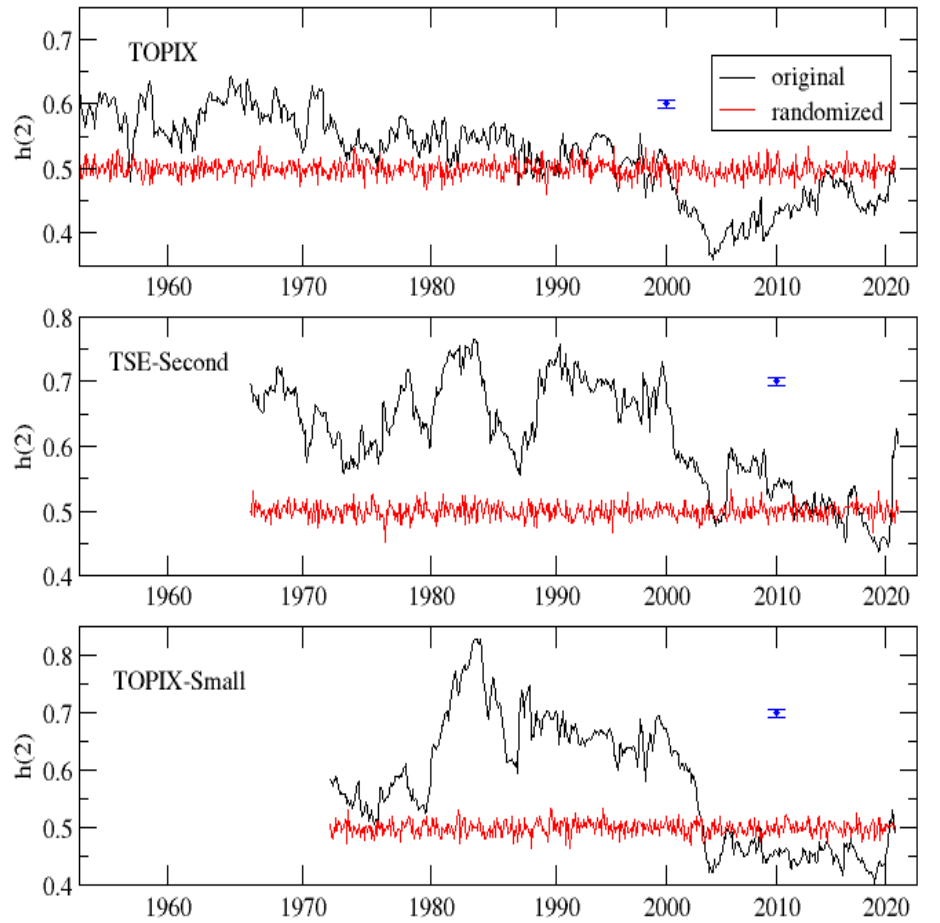
Figure 3. Time evolution of h ( 2 ) for TOPIX, TSE-Second, and TOPIX-Small. The red lines show h ( 2 ) calculated from the 20 randomized time series. The blue symbols with error bars represent a typical fitting error level of